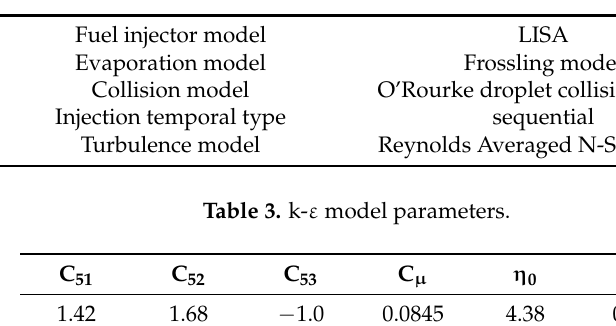
Table 2. Physical model.